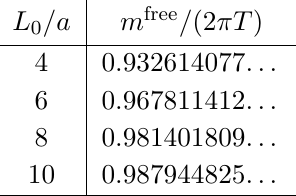
Table 10 . Tree-level values of the non-singlet screening masses on lattices with temporal extension L 0 /a , infinite spatial volume, and shift vector ξ = (1 , 0 , 0) . Notice that ¯ C + ¯ C = ¯ C − ¯ C . For the shift vector ξ = (1 , 0 , 0) , the minimum of ˆ ω is S P V µ A µ attained for ( p , p , p ) = ( π , π , 0) for all correlators we are interested in. The 0 1 2 2 L 0 2 L 0